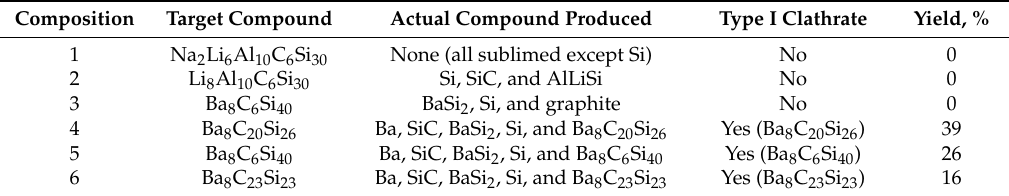
Table 4. Summary of targeted compounds and actual compounds produced by arc-melting. From Chan et al. [8]. Reprinted with permission from Springer.